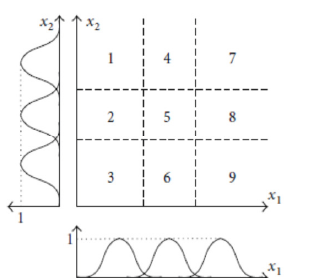
Figure 3. partition of the feature space (Sun and Jang, 1993).